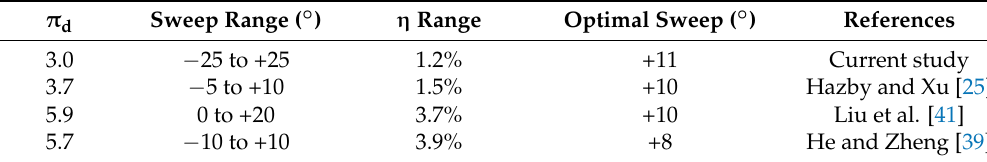
Table 2. Optimal sweep design in transonic impellers.